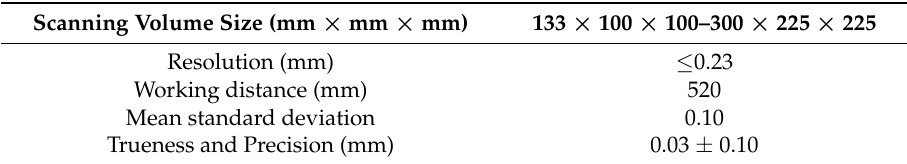
Table 1. The results of the first experimental campaign.